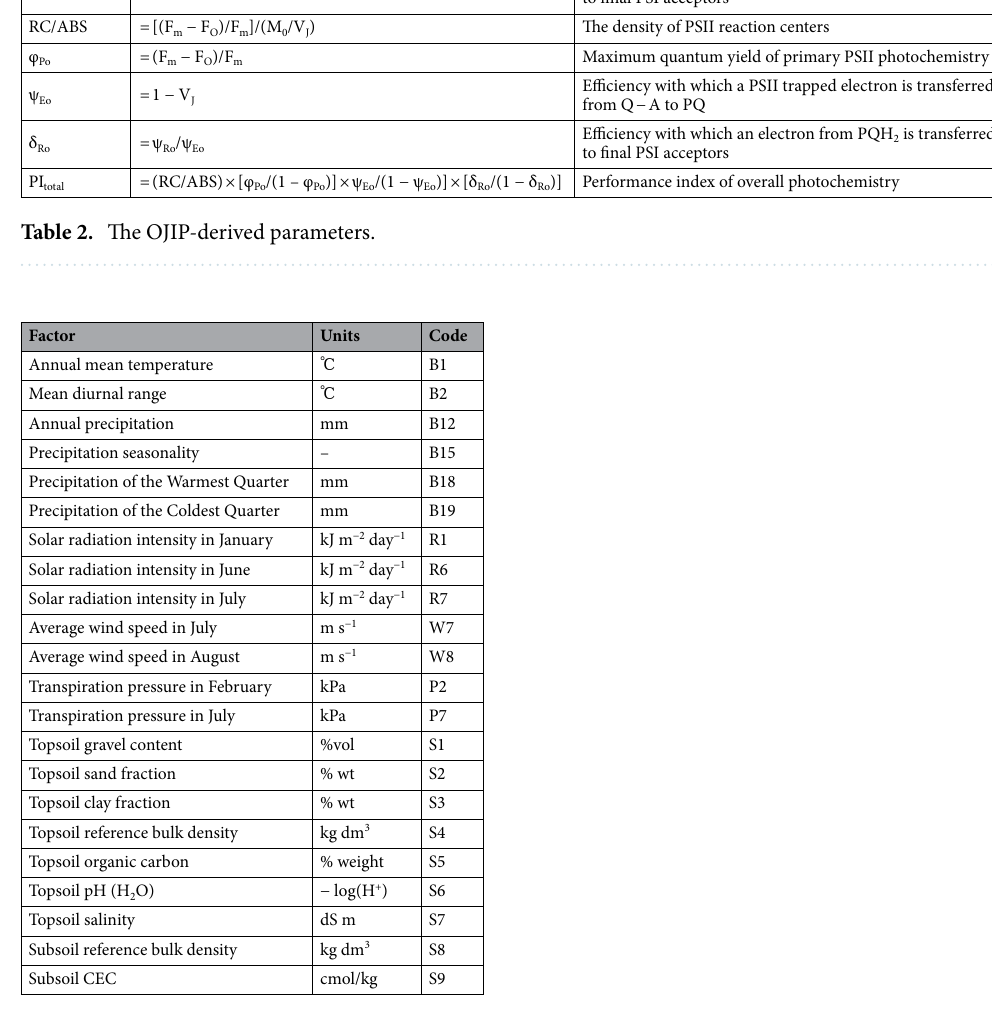
Table 3. Environmental factors for the geographical location of Quercus liaotungensis provenances after eliminating collinearity. The topsoil depth is defined as 0–30 cm, and the subsoil depth is defined as 31–100